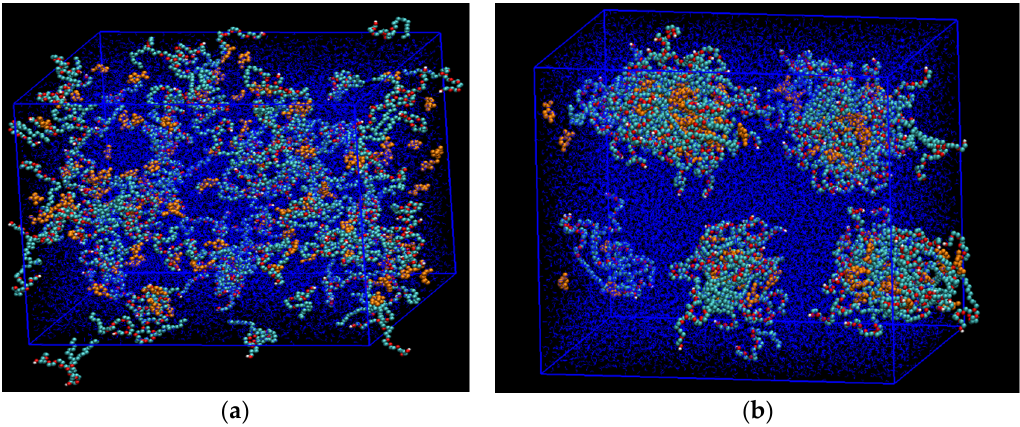
Figure 1. A snapshot of the molecular dynamics (MD) simulations of the aqueous phase showing the development of the stabilized microemulsion droplets. ( a ) Starting condition, where C 12 E 7 surfactant (cyan color) and the solubilized d-limonene solvent molecules (yellow color) were placed randomly inside the box with periodic boundary condition; ( b ) After 50 nanoseconds, the microemulsion droplets were established and stabilized at standard conditions. Water molecules are shown as blue dots.